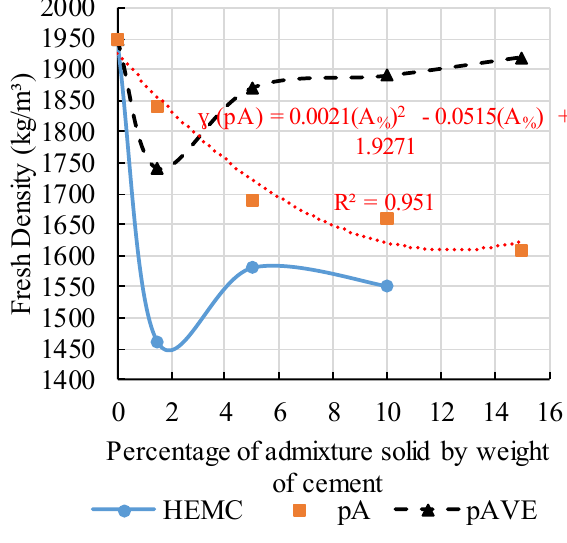
Figure 6. Fresh density